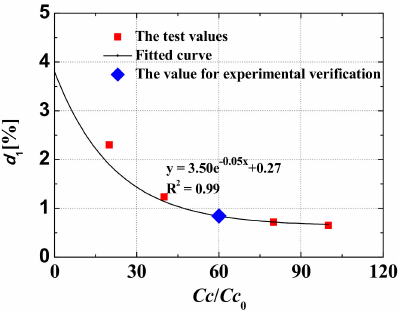
Figure 12. The relationship of parameter d 1 and cement content Cc